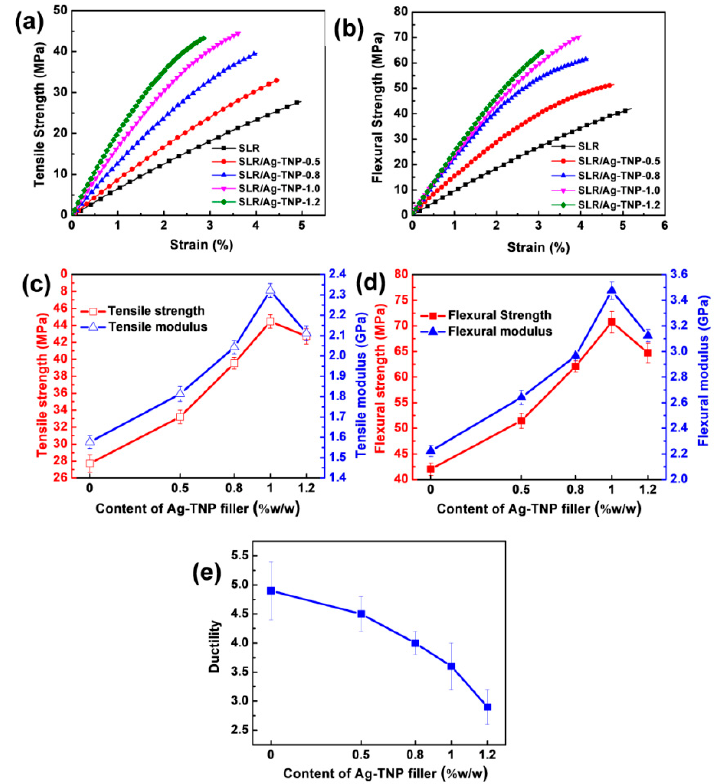
Figure 6. The mechanical properties analysis of neat SLR and SLR/nanofillers. ( a ) the comparative tensile strength analysis of SLR/Ag-TNP at different concentrations, ( b ) the comparative flexural strength analysis of SLR/Ag-TNP at different concentrations, ( c ) the complete data set of tensile study analysis of neat SLR and SLR/Ag-TNP nanocomposites, ( d ) flexural strength and flexural modulus, with SLA 3D printed samples prepared with various concentration SLR/Ag-TNP, and ( e ) the ductility study analysis of SLR/Ag-TNP at different concentrations. Table 1. The tensile strength and tensile modulus of SLR/Ag-TNP and neat SLR nanocomposites. Tensile Properties Strain Sample Strength (%) (MPa)